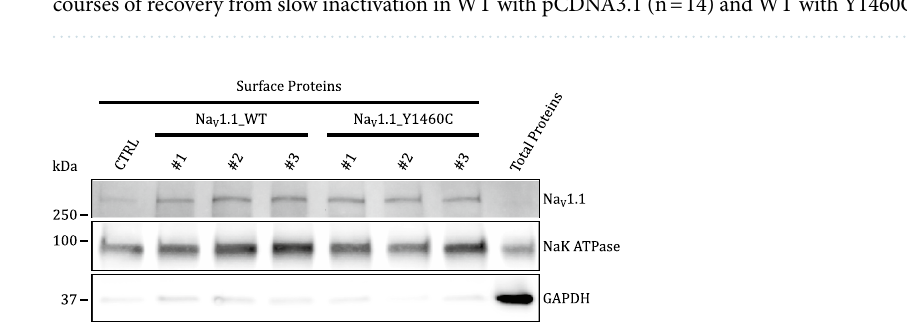
Figure 4. Biotinylation of cell surface proteins and Western blot analysis. Western blot of biotinylated cell surface proteins isolated from HEK293 cells transfected with the Na V 1.1/WT channel and the Na V 1.1/Y1460C mutant channel. Cropped images of western blots blots are shown for three different transfections. Original blots are presented in Supplementary Fig. 1 NaKATPase was used as a house keeping gene and GAPDH as a negative control for cytosolic protein contaminants. CTRL represents a non-transfected biotinylated control. Raw Extract represents proteins prior to purification (10